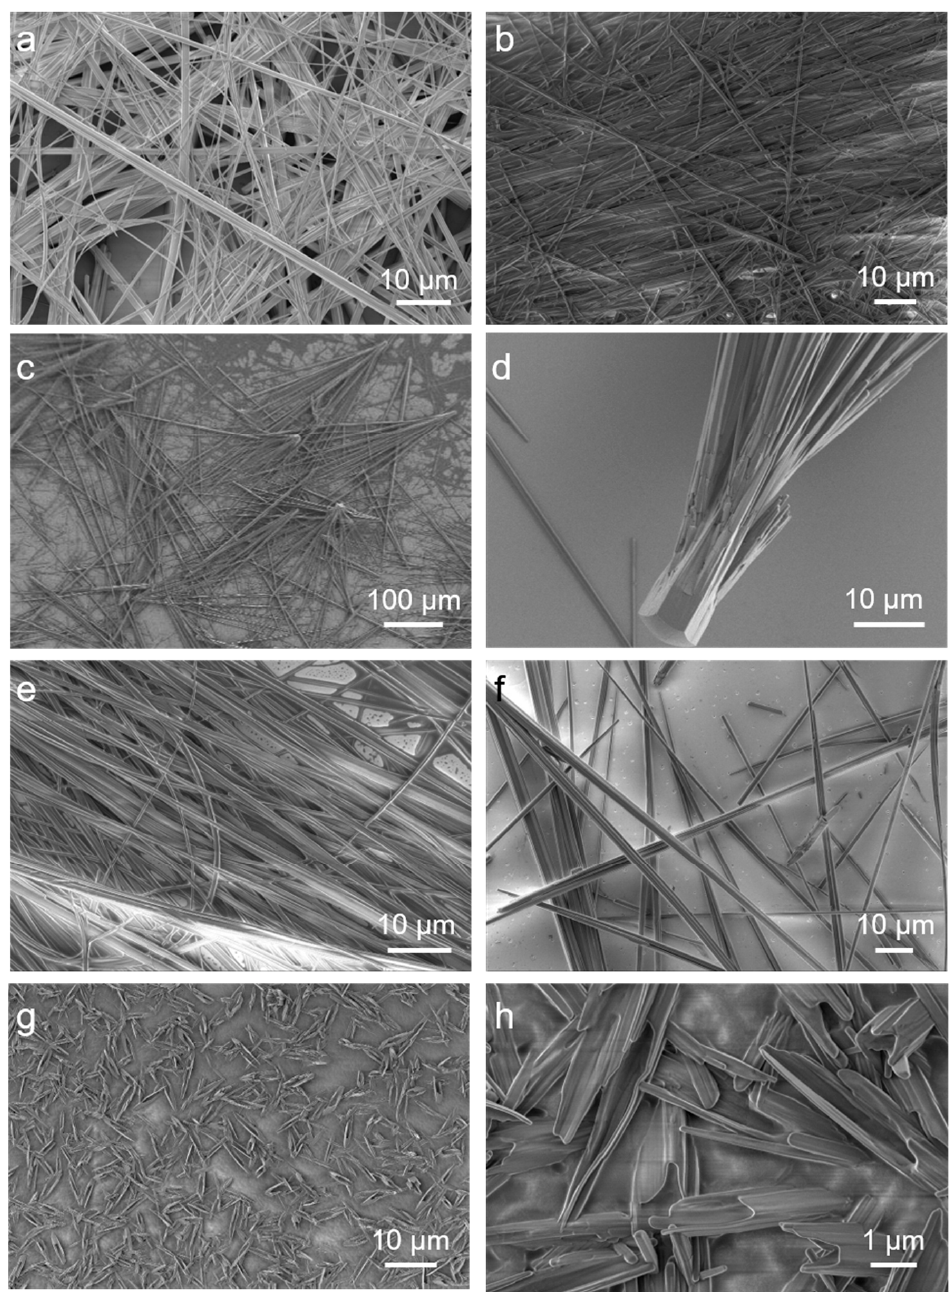
Figure 2. The SEM images of FF/NaC mixtures at NaC concentrations of ( a ) 0, ( b ) 1, ( c , d ) 5, ( e ) 20, ( f ) 300, and ( g , h ) 500 mmol/L, with the fixed FF concentration of 10 mmol/L. Then, we increased the concentration of FF with a fixed NaC at 10 mmol/L. When the FF is above 30 mmol/L, the aggregates assemble smaller 20–50 µ m-long broom-like crystals (Figure 3). The broom-like structures and sizes do not change even when we increase the FF concentration to the maximum value (about 60 mmol/L).